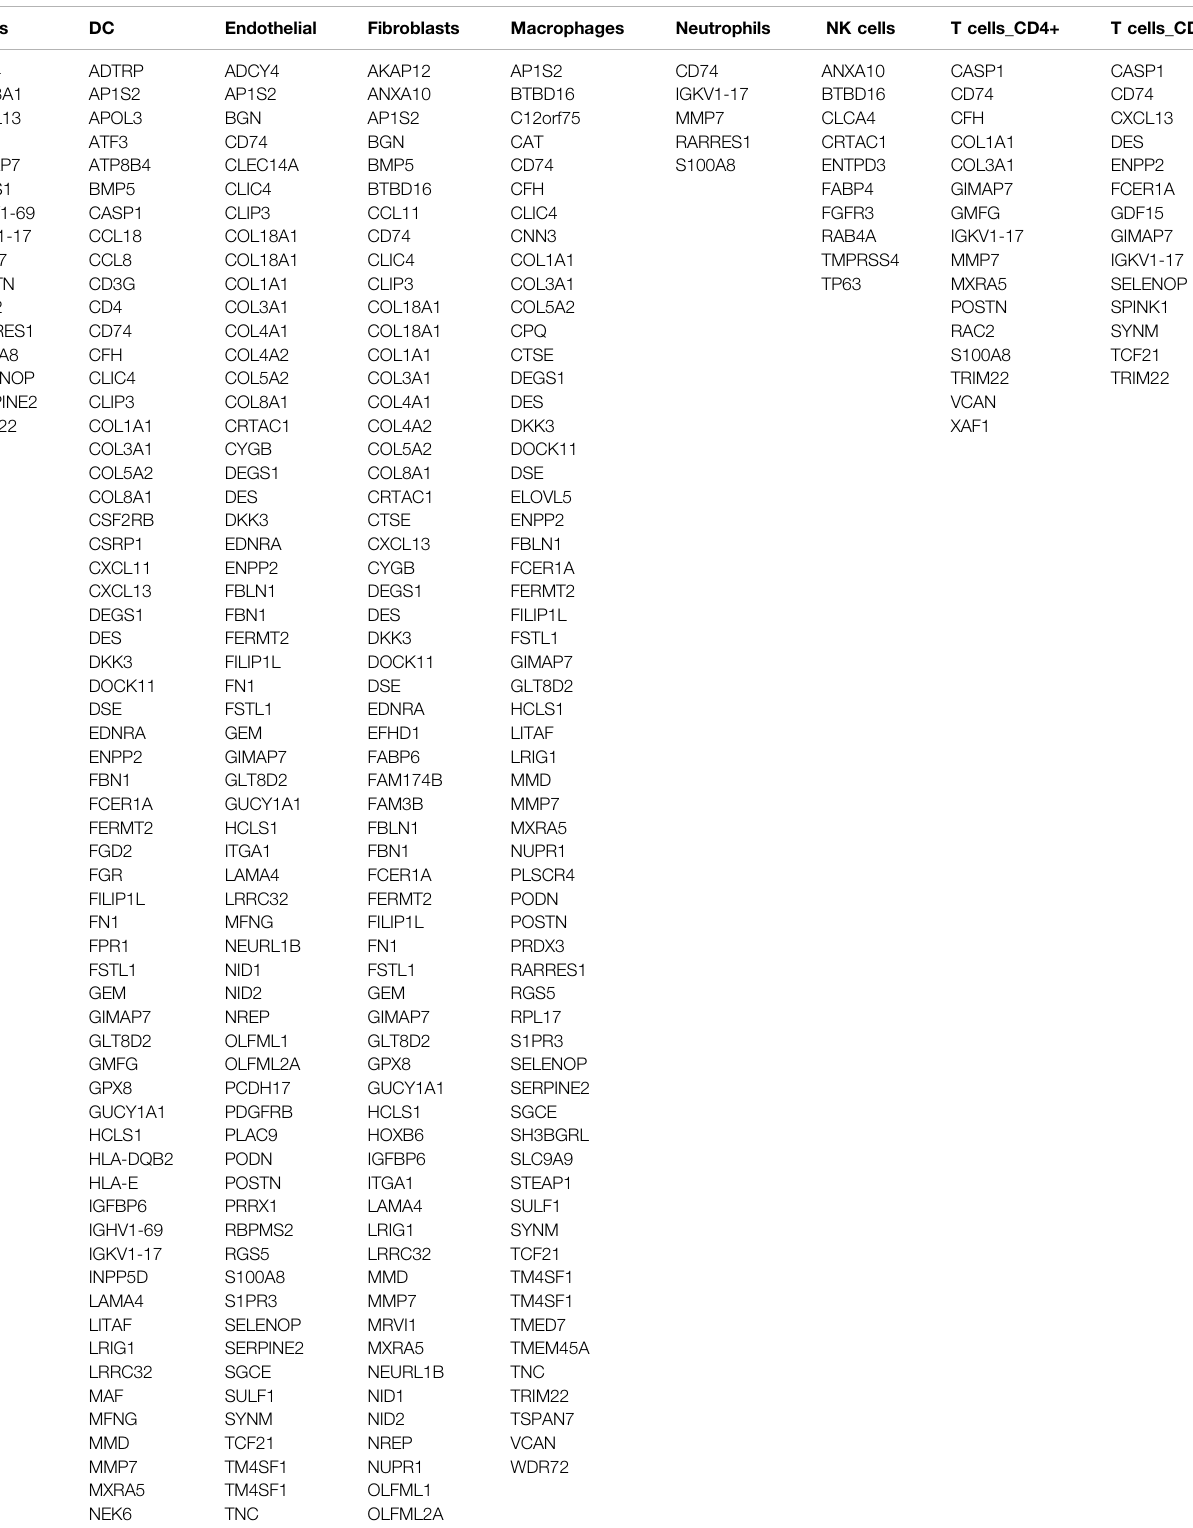
TABLE 2 | List of biomarker genes representing the nine tumor-in fi ltrating candidate immune cells.